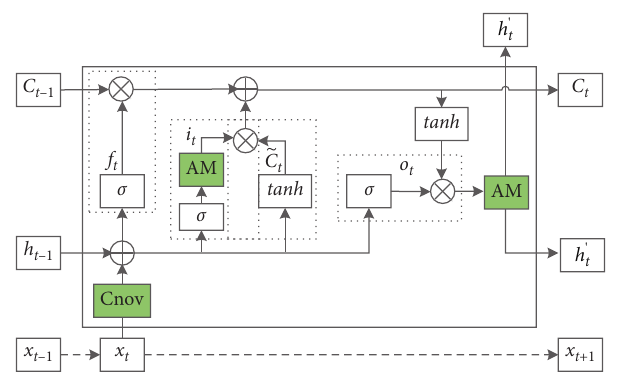
Figure 3: Network structure of improved